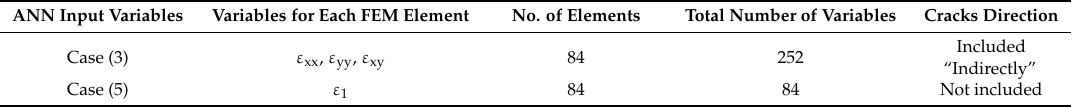
Table 4. Two sets of input variables to show cracks direction significance.